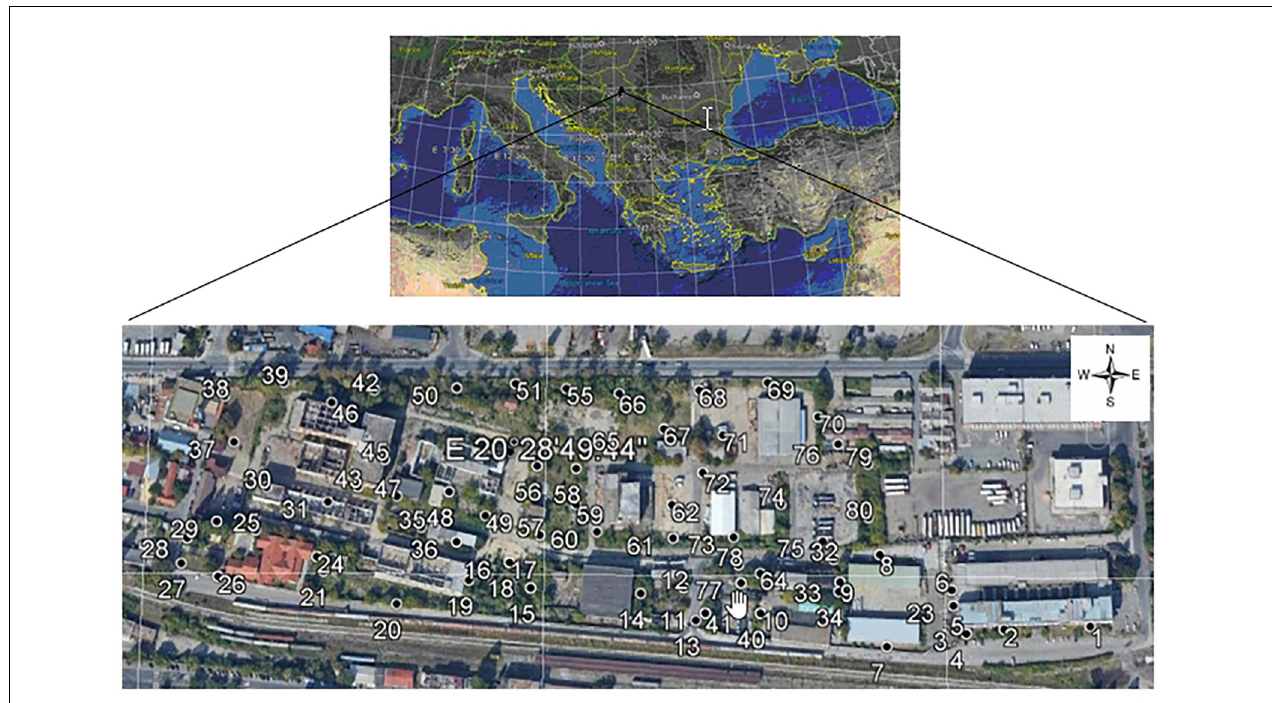
FIGURE 1 | Map of the study area and distribution of sampling